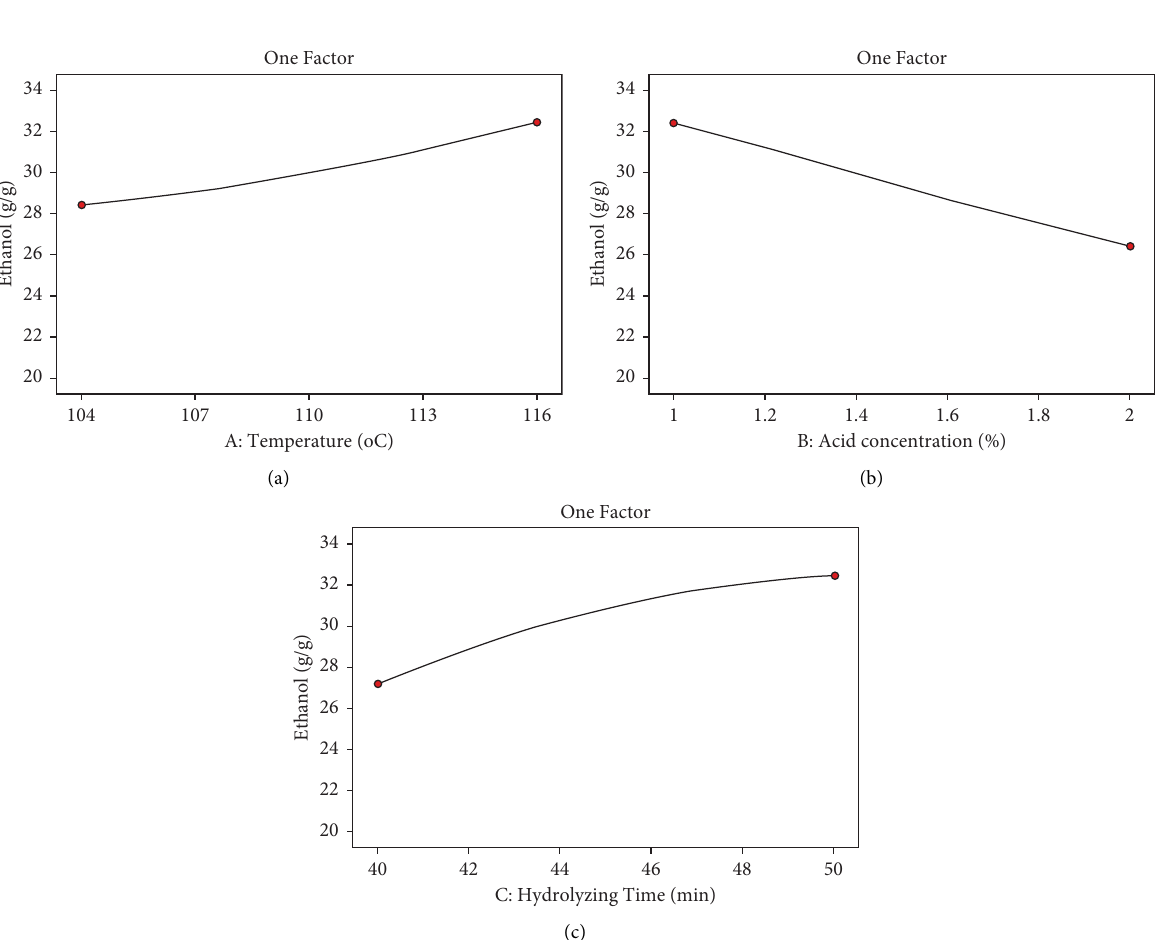
Figure 3: (a) The effects of temperature on the yield of ethanol. (b) The effects of acid concentration on the yield of ethanol. (c) The effects of hydrolyzing time on the yield of ethanol.